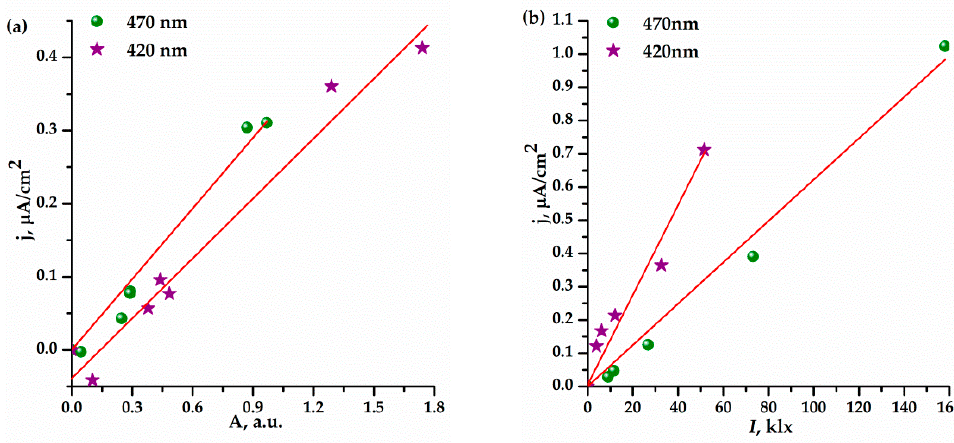
Figure 4. ( a ) Dependence of the photocurrent on the optical density of the poly [Ni(SalPhen)]:[Zn(TPPS)]